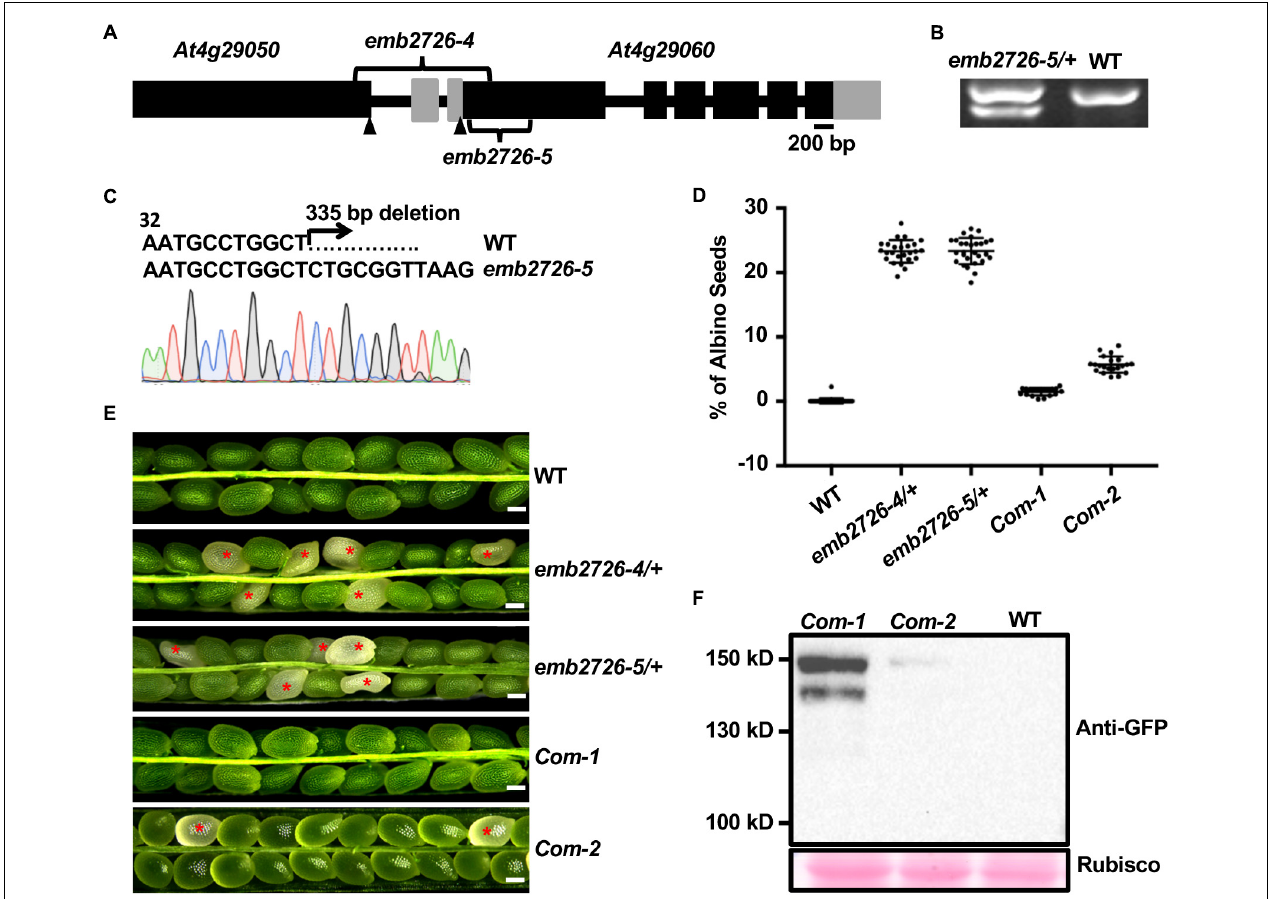
FIGURE 1 | Characterization of the emb2726 mutants and complementation lines. (A) Schematic diagram of the EMB2726 gene with the deletion sites of emb2726-4 and emb2726-5 . Black boxes, gray boxes, and black lines represent exons, untranslated regions, and introns/intergenic sequences, respectively. Arrowheads point to the ATG (start codons) in the two neighboring genes. (B) Genotyping results for an emb2726-5/ + plant; the lower band in emb2726-5/ + shows the deletion allele. (C) Sequencing chromatogram of the mutated emb2726-5/ + sequence generated by CRISPR/Cas9. (D) Percentage of albino seeds as shown in (E) . (E) Seed phenotypes within siliques from wild-type (WT) plants, emb2726-4/ +, emb2726-5/ +, and two complementation lines ( Com-1 and Com-2 ). The complementation lines were generated using p EMB2726:EMB2726-YFP transformed into the emb2726-4 /+ background. Scale bar = 0.2 mm. Red asterisks indicate albino seeds. (F) Immunoblot analysis of EMB2726-YFP expression in the two complementation lines and WT. EMB2726-YFP was detected using anti-GFP antibodies; Rubisco staining by Ponceau S was used to indicate equal loading.